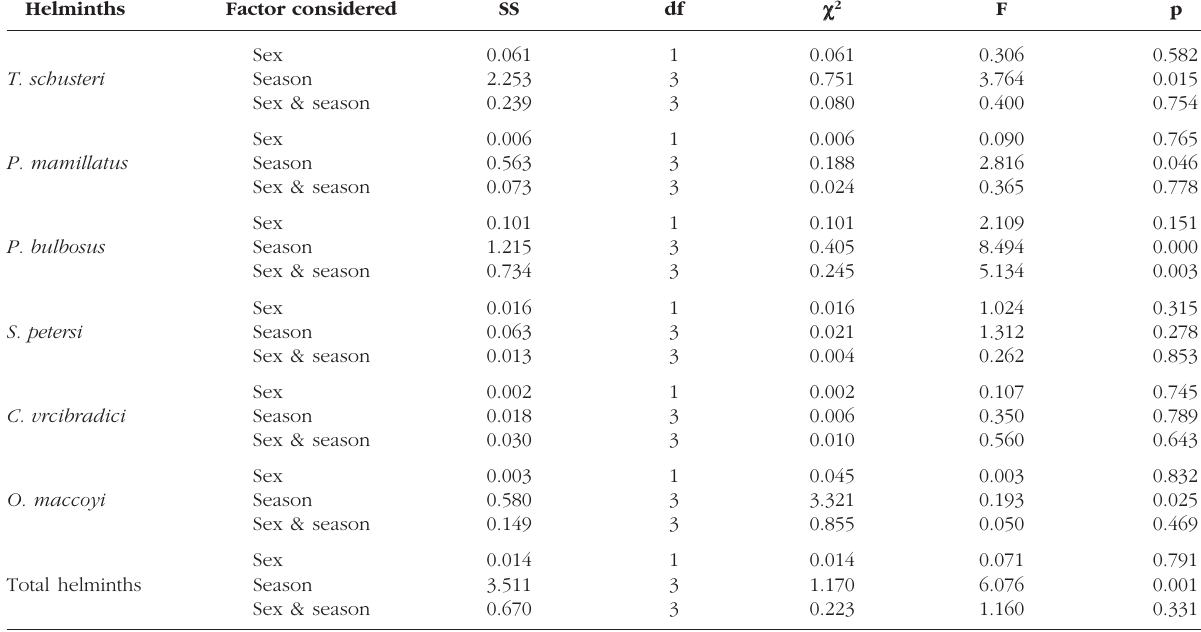
Helminths Factor considered SS